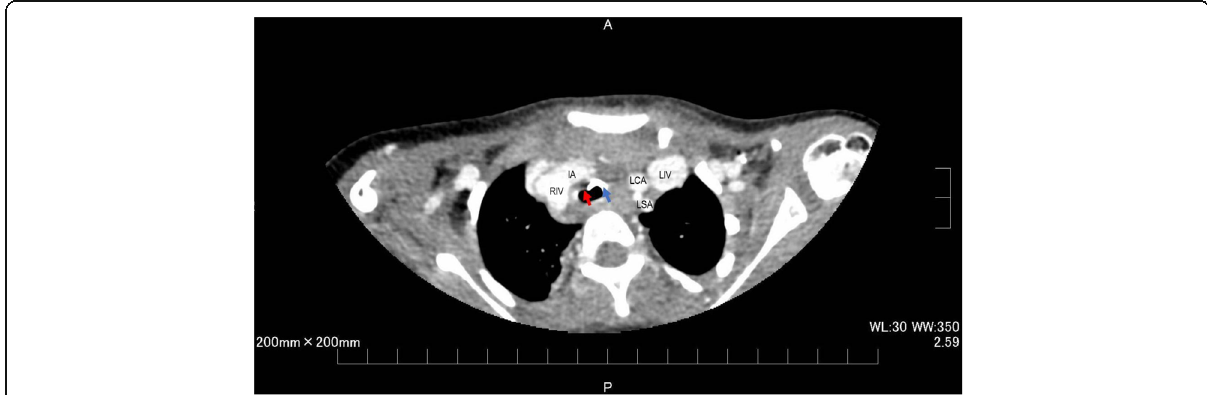
Fig. 1 Preoperative contrast-enhanced computed tomography. Computed tomography demonstrated the innominate artery was in contact with the trachea. Red and blue arrow shows tracheo-innominate artery fistula and the tip of cannula, respectively. IA; innominate artery, RIV; right innominate vein, LCA; left common carotid artery, LSA; left subclavian artery, LIV; left innominate